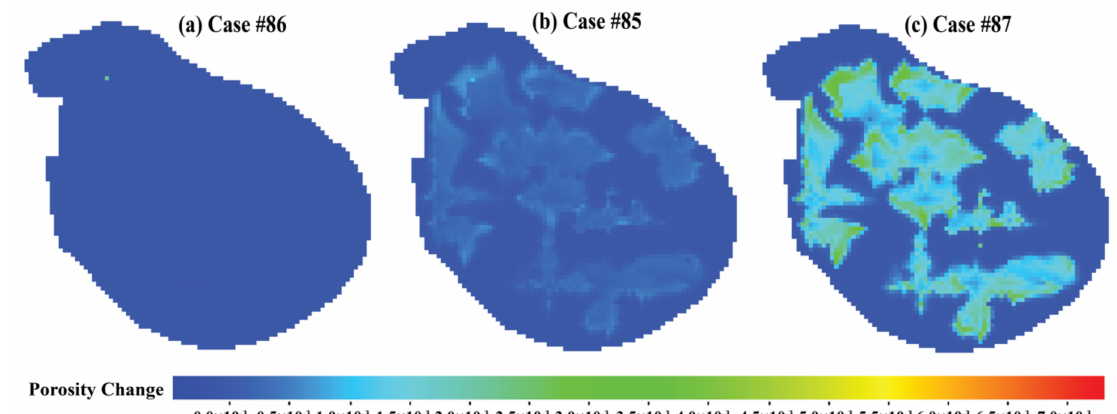
Figure 8. Estimated porosity loss at the end of the post-EOR CO 2 injection period compared to the initial values for ( a ) Case #86, ( b ) Case #85, and ( c ) Case #87. After ten years of CO 2 -EOR operation, porosity reduction is observed in all three